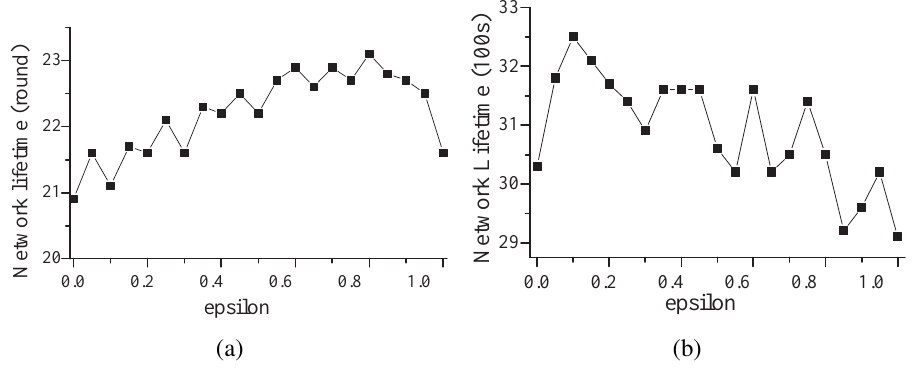
Figure 4. The impact of † on the network lifetime for (a) scenario 1 and (b) scenario